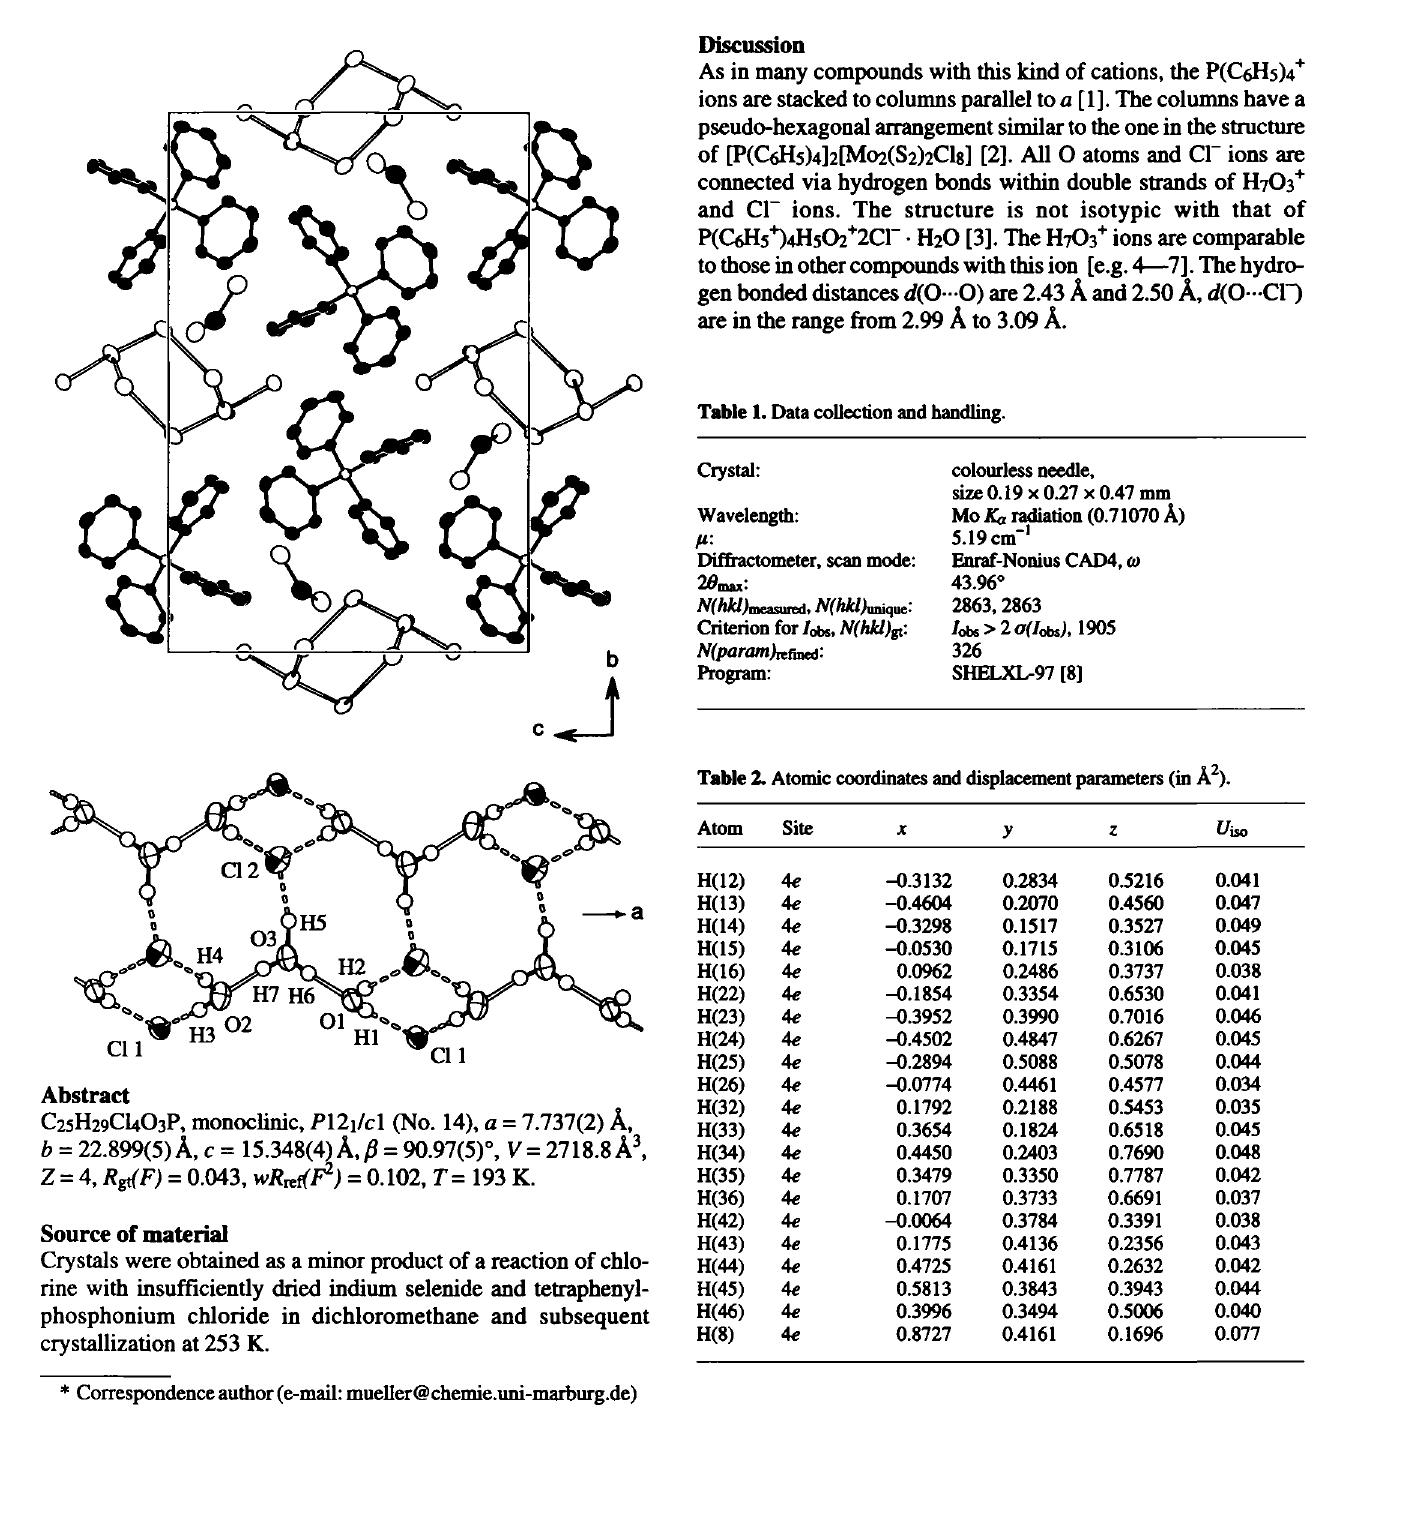
Table 1. Data collection and handling.